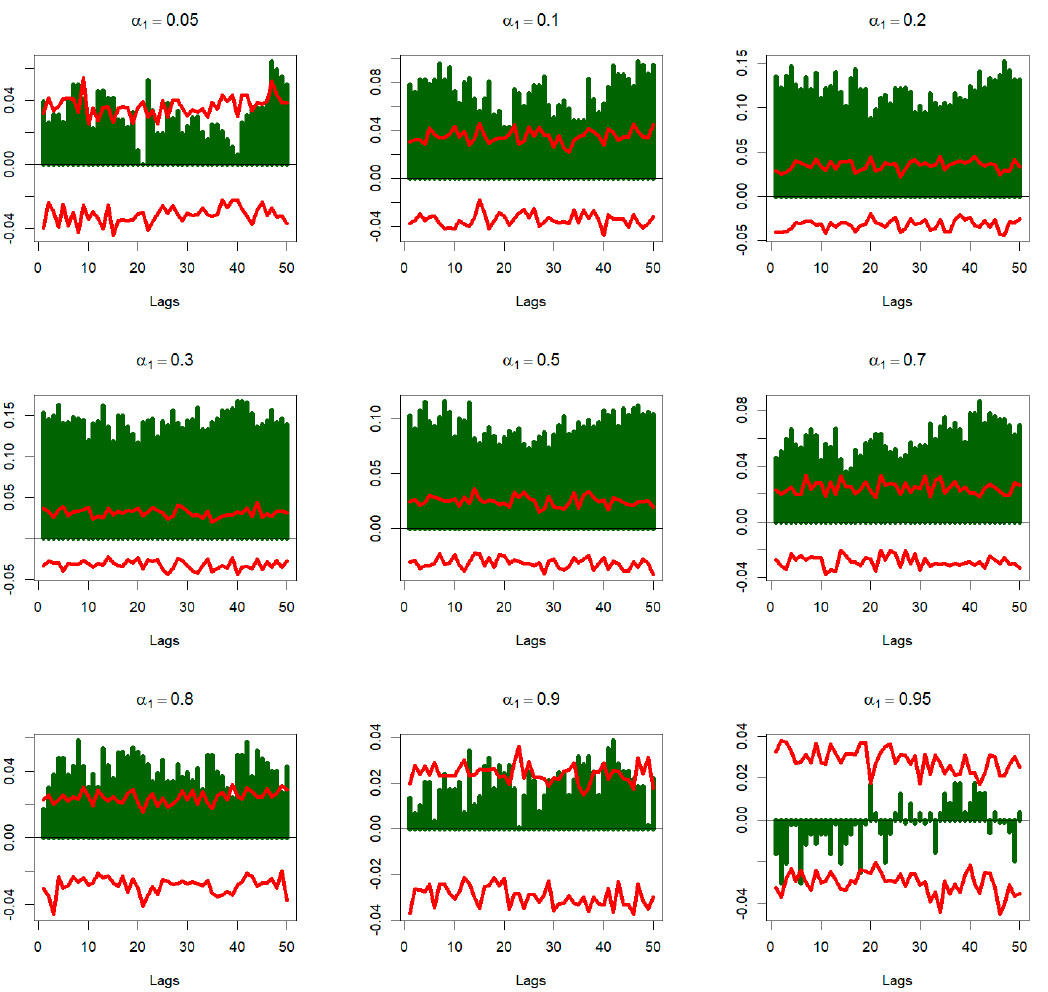
Figure 1. Sample cross-quantilograms for the low levels of TVRAs, i.e., for α 2 = 0.1. Note: This figure depicts the sample cross-quantilograms ( ˆ q a ( k )) to detect directional predictability from time-varying risk aversion measure (TVRA) to realized correlation jumps ( RCJ t ) , by estimating the lead-lag correlations contemporarily at di ff erent lags and quantiles. As for RCJ t , six quantiles are considered, in which ∈ { 0.05,0.10,0.20,0.30,0.40,0.5,0.60,0.70,0.80,0.9,0.95 } As for TVRA, three quantiles are considered, α 1 in which α 2 ∈ { 0.1 } corresponding to periods in which the TVRA is in its low levels. Bar graphs depict the ˆ q a ( k ) , while the red lines depict the 95% bootstrap confidence intervals for 1000 bootstrap iterations. For positive (negative) values of the ˆ q a ( k ) , a bar above (below) the red line leads to a rejection of the null hypothesis H 0 : ˆ q a ( k ) = 0 at a 5% significance level.